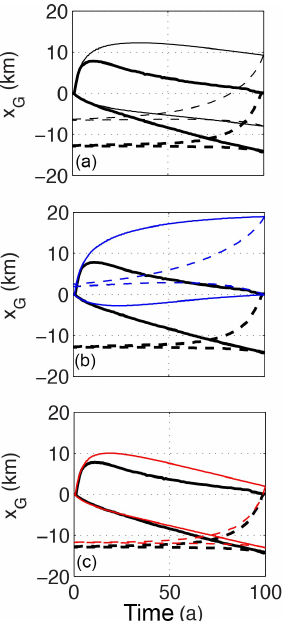
Figure 6. GL evolution on both the symmetry axis (upper curves) and free-slip boundary (lower curves) for the P75S (solid curves) and P75R (dashed curves) comparisons between FELIX-S (bold- black curves) and Elmer/Ice DI ( a , thin black curves), LG ( b , thin blue curves), and FF ( c , thin red curves). The number of elements along the y direction is 20 ( (cid:49)y = 2500m). Note that GL positions are plotted relative to their equilibrium positions in the Stnd exper- iment.